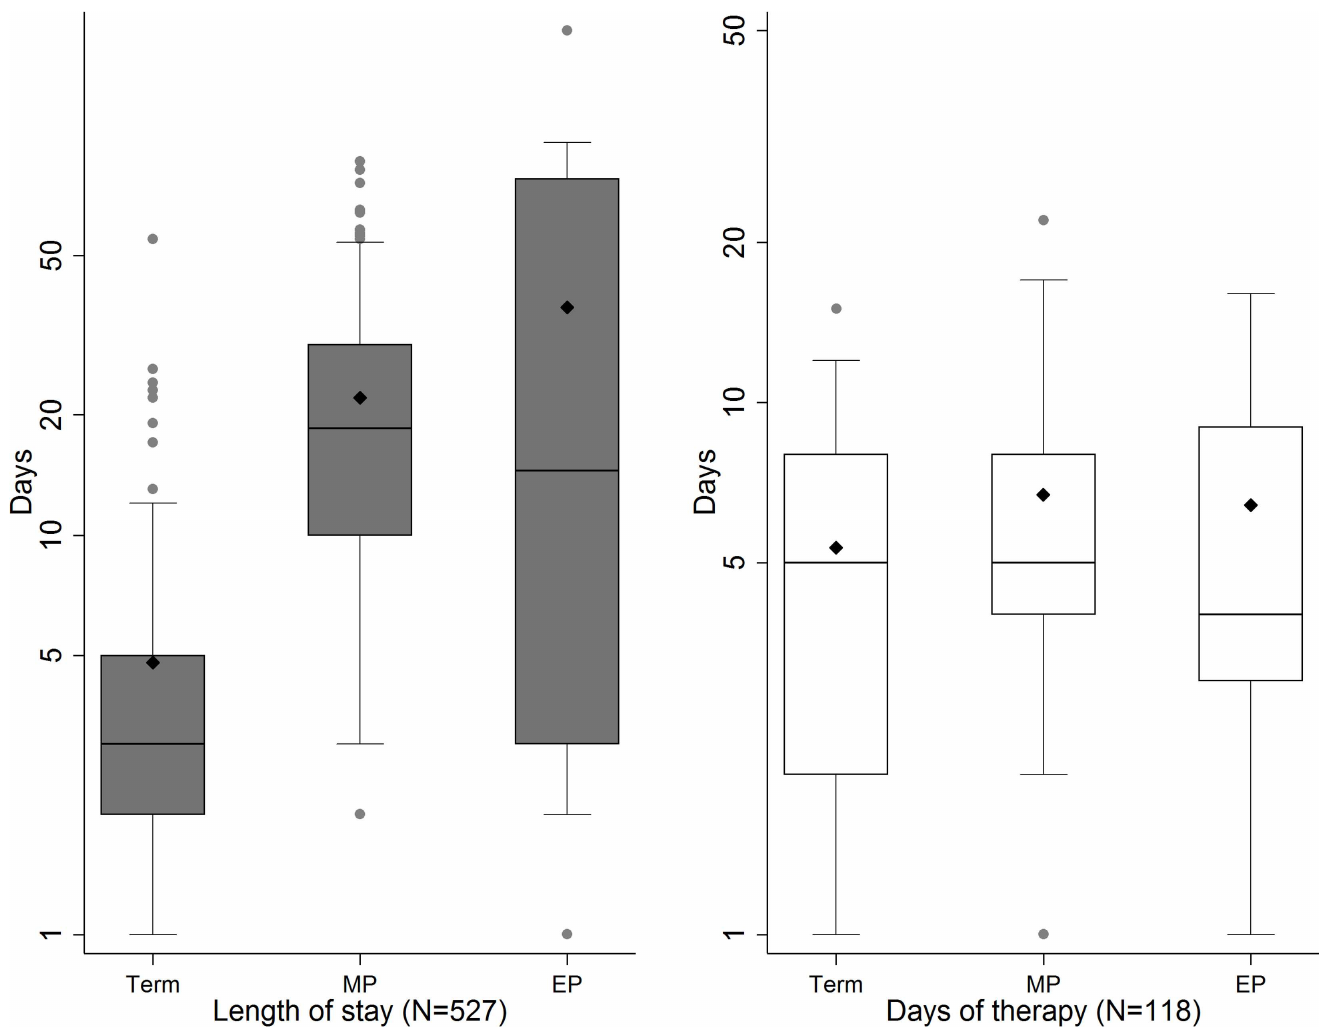
Fig 4. Boxplot with mean ( ◆ ) for length of stay and days of therapy for infants by degree of prematurity. Abbreviations: MP = Moderately premature, EP = Extremely